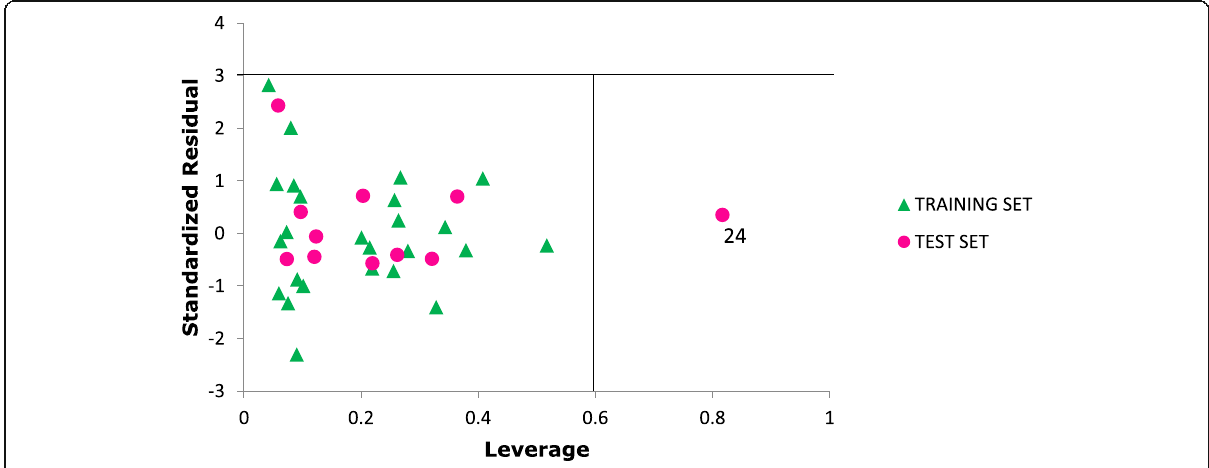
Fig. 4 The Williams plot of the standardized residuals versus the leverage